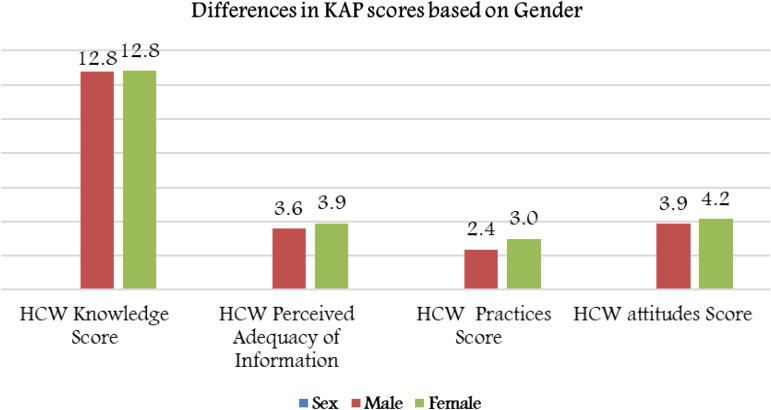
Mean KAP scores and perceived adequacy of information based on gender groups.